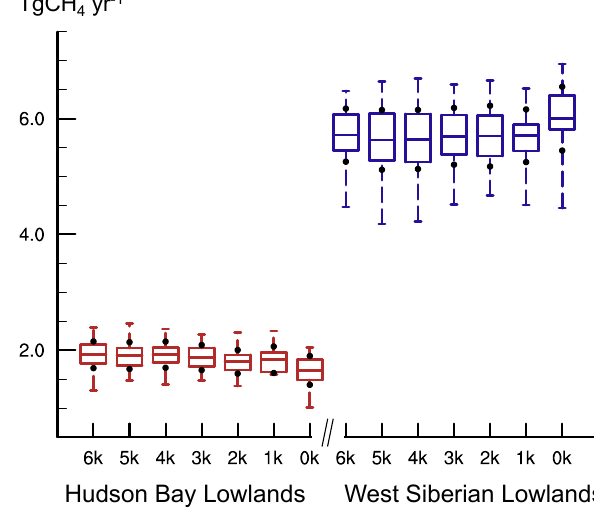
Fig. 7. Methane emissions (gCH 4 m − 2 yr − 1 ) from the time slice simulations for 6000yrBP (left), 3000yrBP (middle) and pre-industrial Fig. 7. (right), averaged over 10yr of model simulation. Carbon fluxes are represented with respect to grid box area.